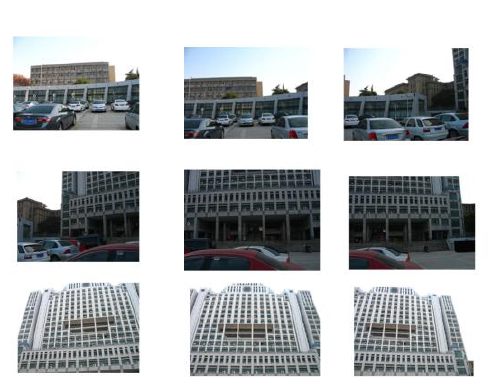
Figure 7b: Images used to reconstruct the scene